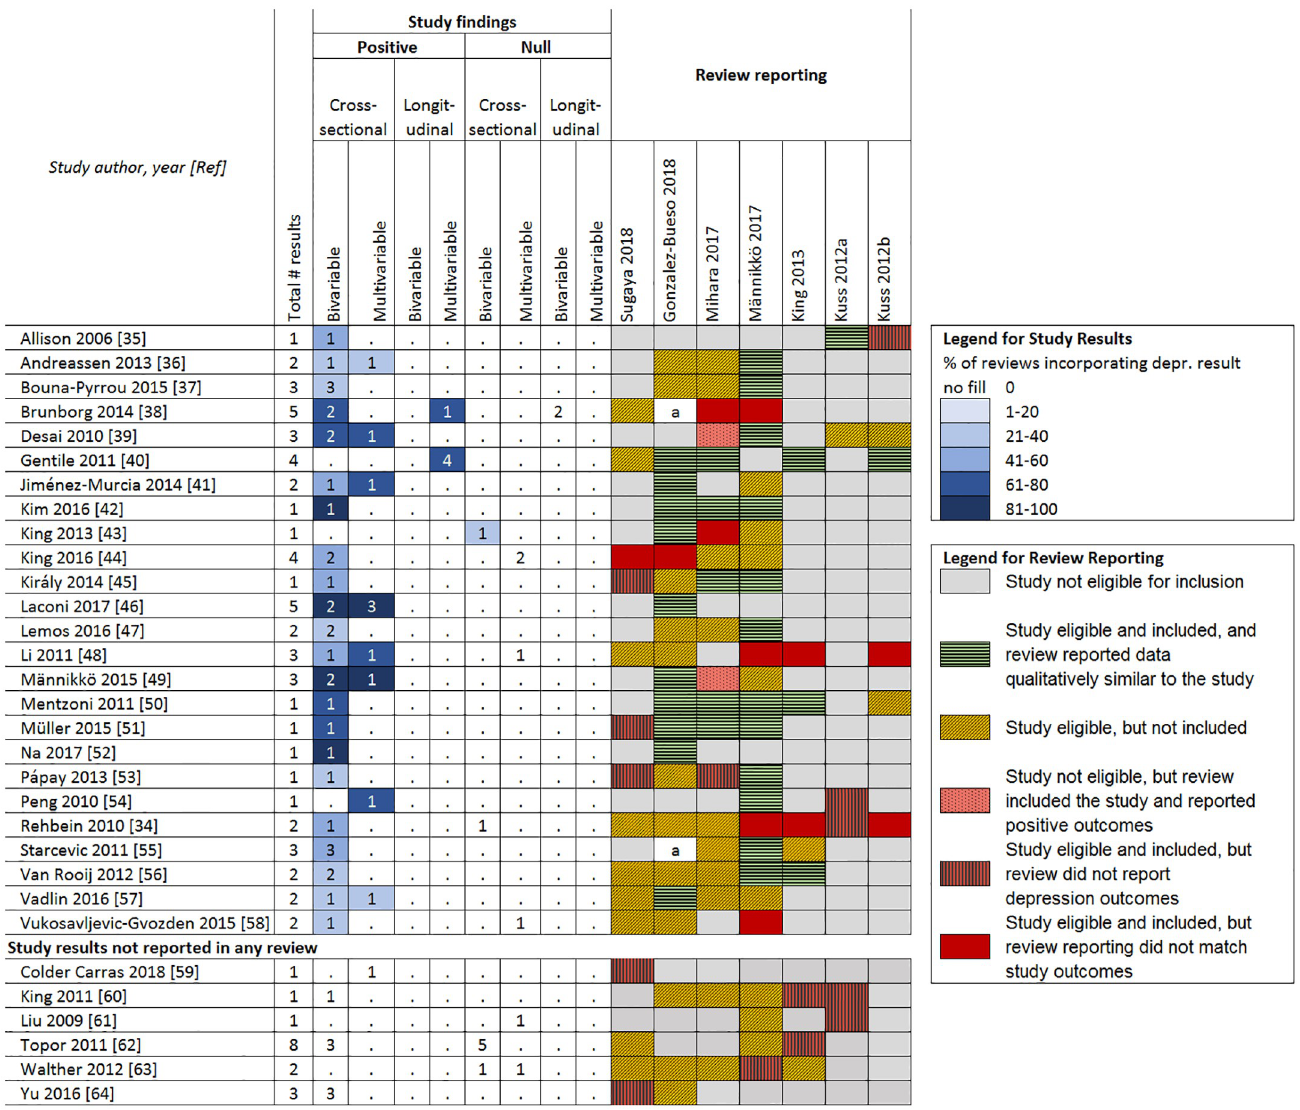
Fig 5. Associations between problematic gaming and depression. a = Composite reporting of outcomes in review made comparisons